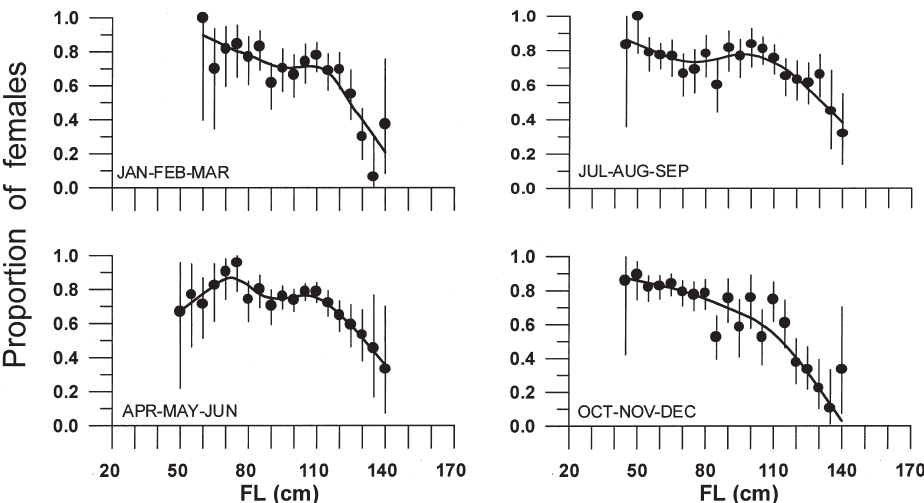
F IG . 4. – Quarterly proportion of female dolphinfish at size for all gears combined. The solid lines represent the locally weighted regression curves and the vertical lines represent 95% binomial confidence intervals.